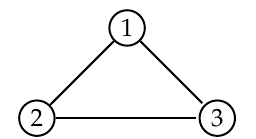
∨ x (cid:48) ) , x ∨ ( x ∧ x )) . 3 2 1 3 1